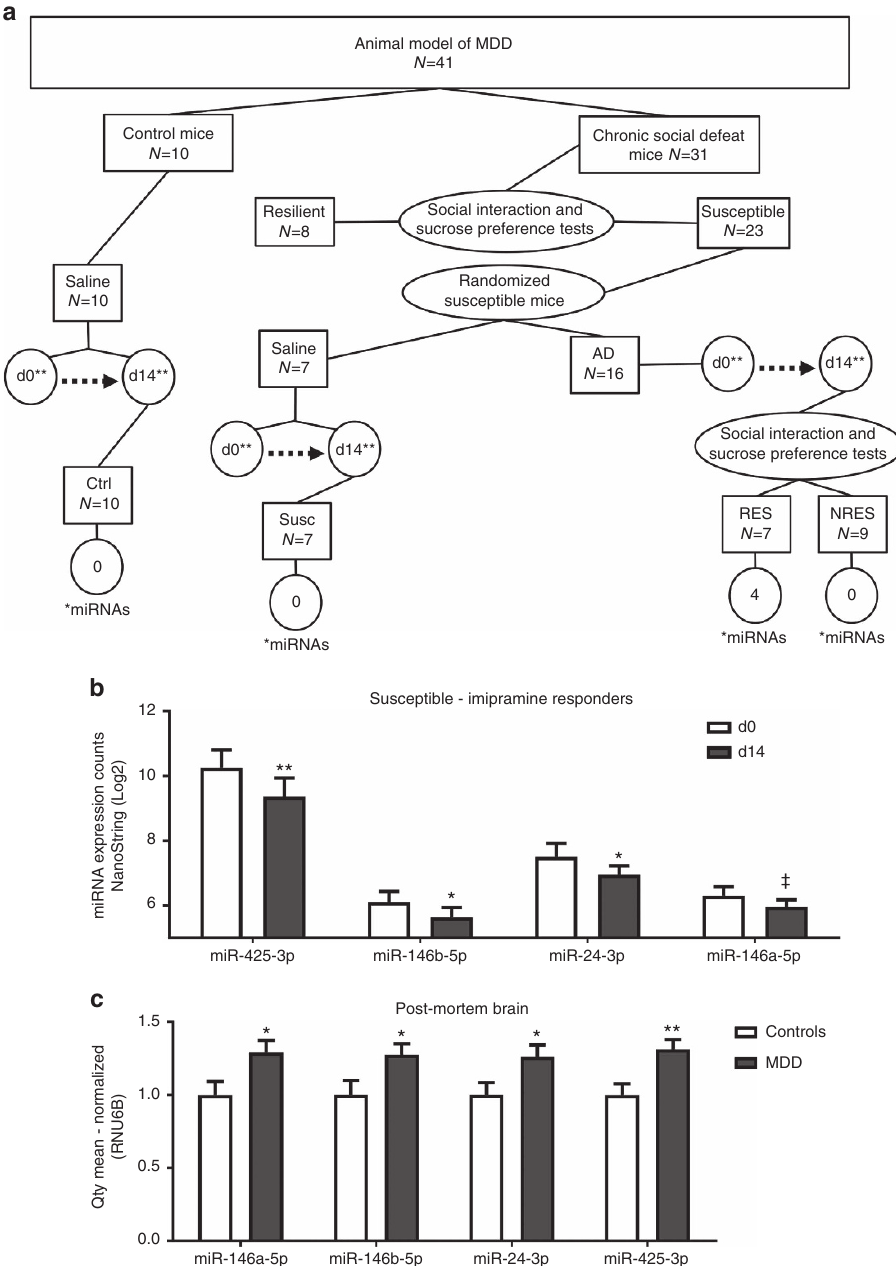
Figure 3 | Expression of miR-146a-5p, miR-146b-5p, miR-24-3p and miR-425-3p in an animal model of MDD and post-mortem human brain samples. ( a ) Experimental design. Mouse model of MDD. Baseline (d0), 14 days of treatment (d14), responders (RES), nonresponders (NRES), susceptible (Susc) and Control (Ctrl). *Number of significant miRNAs. **Mice were treated with imipramine or saline solution. Resilient mice were not studied. ( b ) Differential expression of miR-146a-5p, miR-146b-5p, miR-24-3p and miR-425-3p after 14 days of imipramine treatment in mice by NanoString nCounter Digital Analyzer. * P o 0.05; ** P o 0.01; z P o 0.1. ( c ) Quantitative real-time PCR (qRT-PCR) expression data of miR-146a-5p, miR-146b-5p, miR-24-3p and